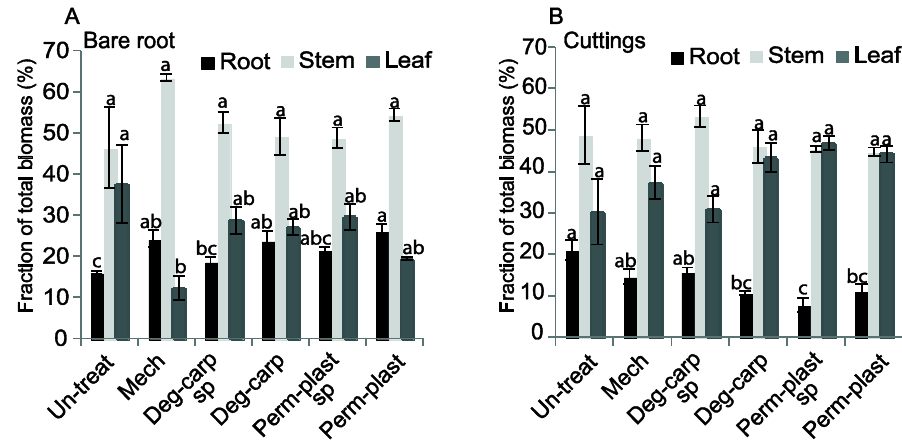
Figure 4. Biomass allocation. Biomass allocation (%) to roots, stems, and leaves in rooted plants ( A ) and un-rooted cuttings ( B ) at the end of the first growing period under each of the treatments: control (Untreat), mechanical vegetation control (Mech), mulching without soil preparation using degradable carpet (Deg-carp) or permanent polypropylene plastic (Perm-plast), and with soil preparation (Perm-plast sp. and Deg-carp sp. ). Values with the same letter (for the same planting material and for the same vegetal tissue) are not significantly different at the p = 0.05 level: means ( n = 3), error bars indicate standard